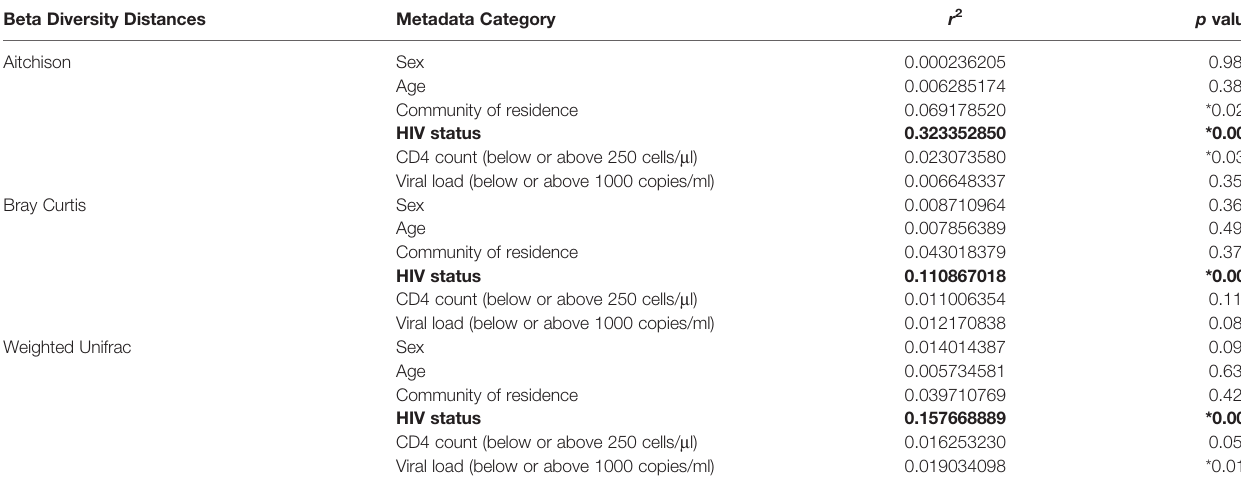
*Asterisks indicate signi fi cant difference. Metadata categories with signi fi cant p-value and r 2 > 0.1 are shown in bold